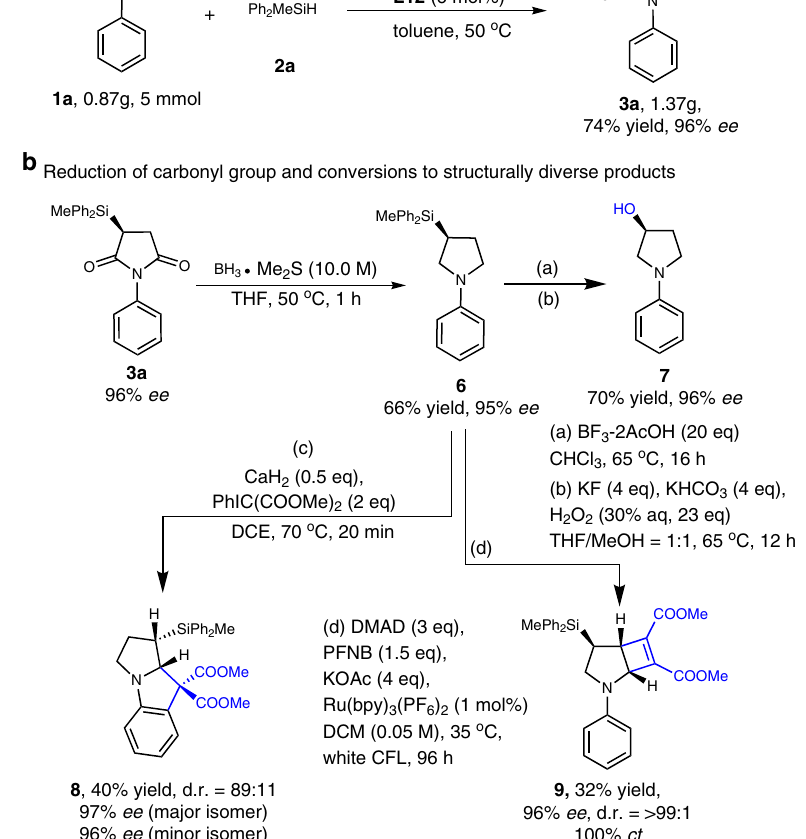
Fig. 4 Gram-sale synthesis and functionalisation and demonstration of utility. a Gram-scale reaction. Compared with the small-scale reaction, using substrates 1a and 2a in a gram-scale reaction produced the desired product 3a with the same level of enantiomeric excess ( ee ) and yield. b The silyl succinimides can be readily reduced to the stable silylpyrrolidine that could be transferred into structurally diverse and chiral N -heterocycles without racemisation. DMAD dimethyl acetylenedicarboxylate, PFNB peta fl uoronitrobenzene, CFL compact fl uorescent light, ct the value of chirality